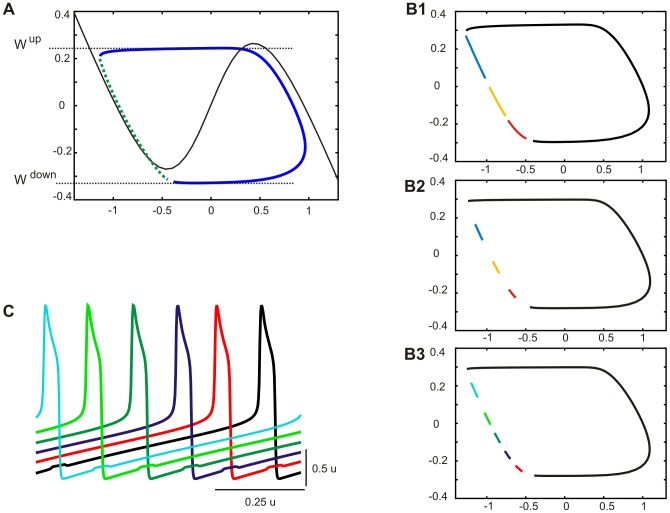
Maximal number of phases in the activity pattern.A. A general shape of a multiphase pattern trajectory. The trajectory (dark blue curve) is placed between limit values of W (Wup and Wdown) (horizontal lines) at which jumps take place. During the silent phase (dotted green curve) a number of deflection may occur (not shown), equal to number of phases in the pattern - 1. The free nullcline is shown as a reference curve (black solid curve). B. Trajectories of cells belonging to different groups expressing 4-phase pattern (B1-2) or 6-phase pattern (B3) during a full active phase of a single cell. For the 4-phase pattern shown are trajectories of cell 1, 7, 13, 19 (black, red, yellow and blue curves, respectively, B1-2). For the 6-phase pattern shown are trajectories of cell 1, 5, 9, 13, 17, 21, (black, dark blue, green, light green and light blue curves, respectively, B3). Notice the effect of shortening the cells' duty cycle (cf. length of trajectories in the silent phase, see color curves in B1 and B2). C. Voltage traces of cells expressing the 6-phase pattern. Only cells connected with a more advanced group are shown. Parameters: N = 24, Ncc = 2, gel = 0.08. Phase plane coordinates: V (abscissa), W (ordinate). Cells numbers as in Fig. 7B (insert).